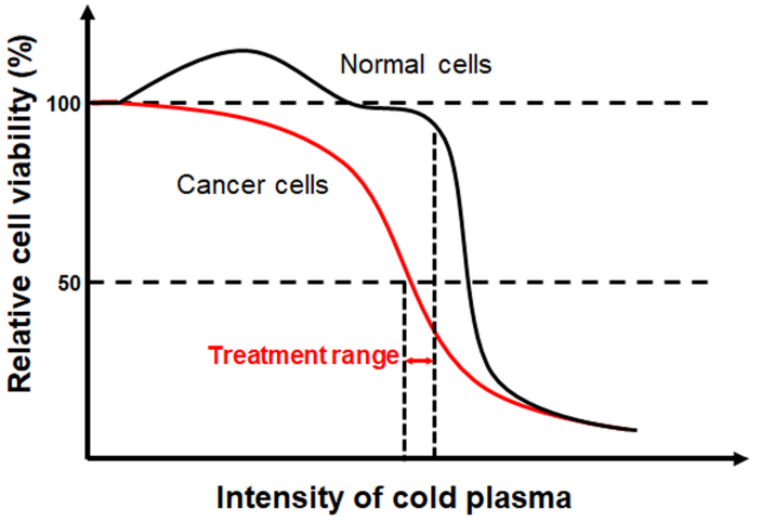
Figure 1. Effects of cold plasma treatment on cell activity [9,10,15,16,39–44,53,54]. The appropriate intensity of cold plasma treatment for cancer and normal cells is the condition that inhibits the viability of cancer cells but does not damage the viability of normal cells. Low-intensity cold plasma treatment shows cell viability improvements for normal cells but does not inhibit cancer cell viability. High-intensity cold plasma treatment inhibits cell viability of both normal and cancer cells. For the treatment ranges of cold plasma for different cancer cells see Table 2.